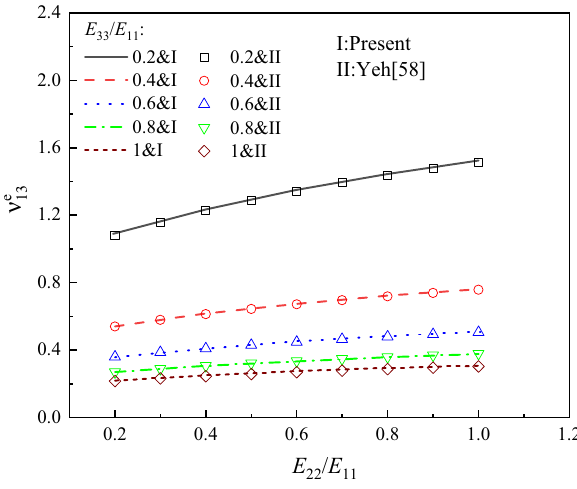
( j = 1, 2, 3, 4 ) [ 24,45 ] j